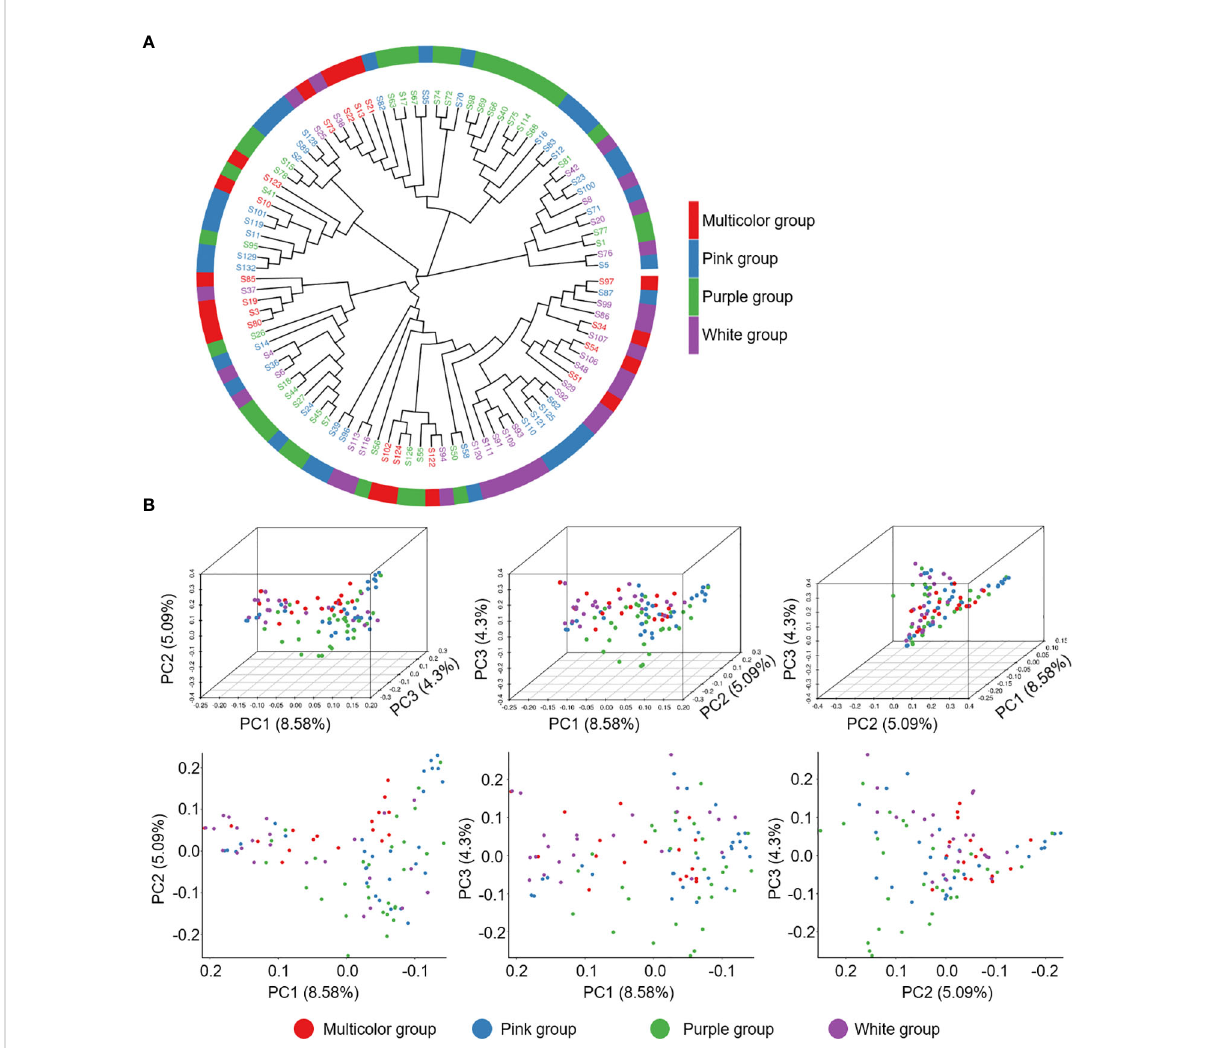
FIGURE 4 Population genetics of 99 P. lacti fl ora accessions. (A) The phylogenetic tree was constructed using Kimura 2-parameter model. Accessions with the same color belong to the same group. (B) Principal components analysis of 99 P . lacti fl ora accessions. Each dot represents an